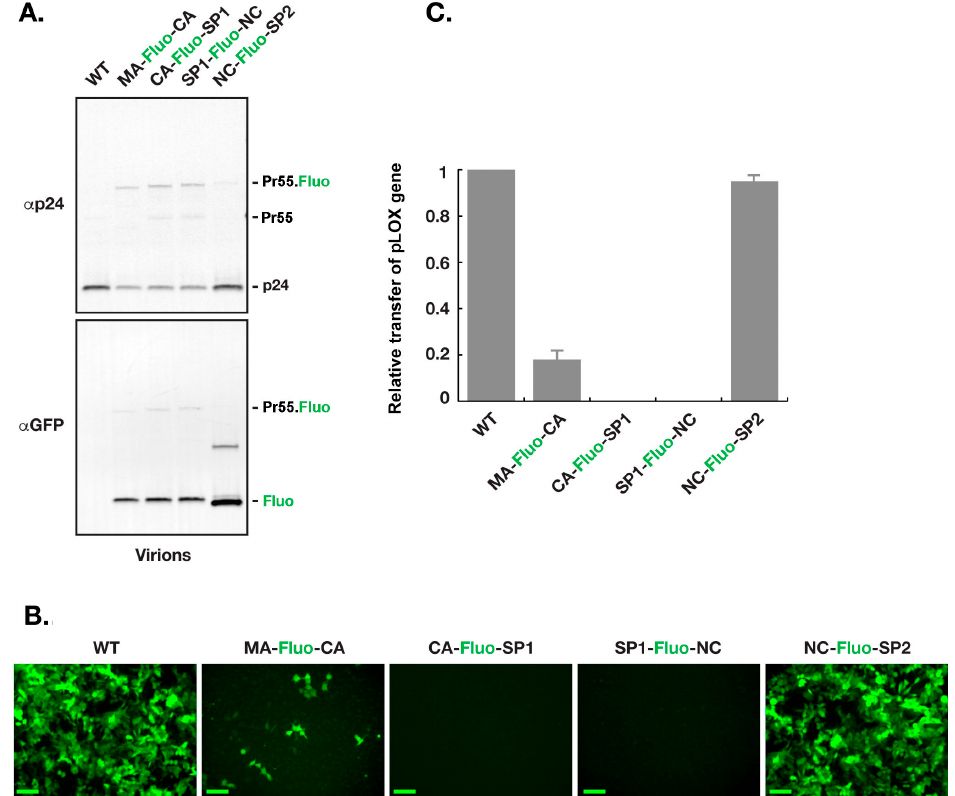
Figure 3. Transfer of pLOX–GFP with R8.2:Gag–Fluo virions. Virions harvested from 293T cells transfected with R8.2 or R8.2:Gag–Fluo vectors along with pLOX–GFP and pCMV–VSV–G plasmids were harvested for analysis. ( A ) Processing analysis of R8.2:Gag–Fluo virions using immunoblotting. Equal load of virions, based on density of the p24 band, were used for western blot analysis. ( B ) Equal load of virions, based on density of the p24 band, were used to infect a monolayer of Hela cells. Images show the cells 48 h post infection. Scale bars: 100 µ m. ( C ) Quantitative assessment of the number of GFP expressing cells in ( B